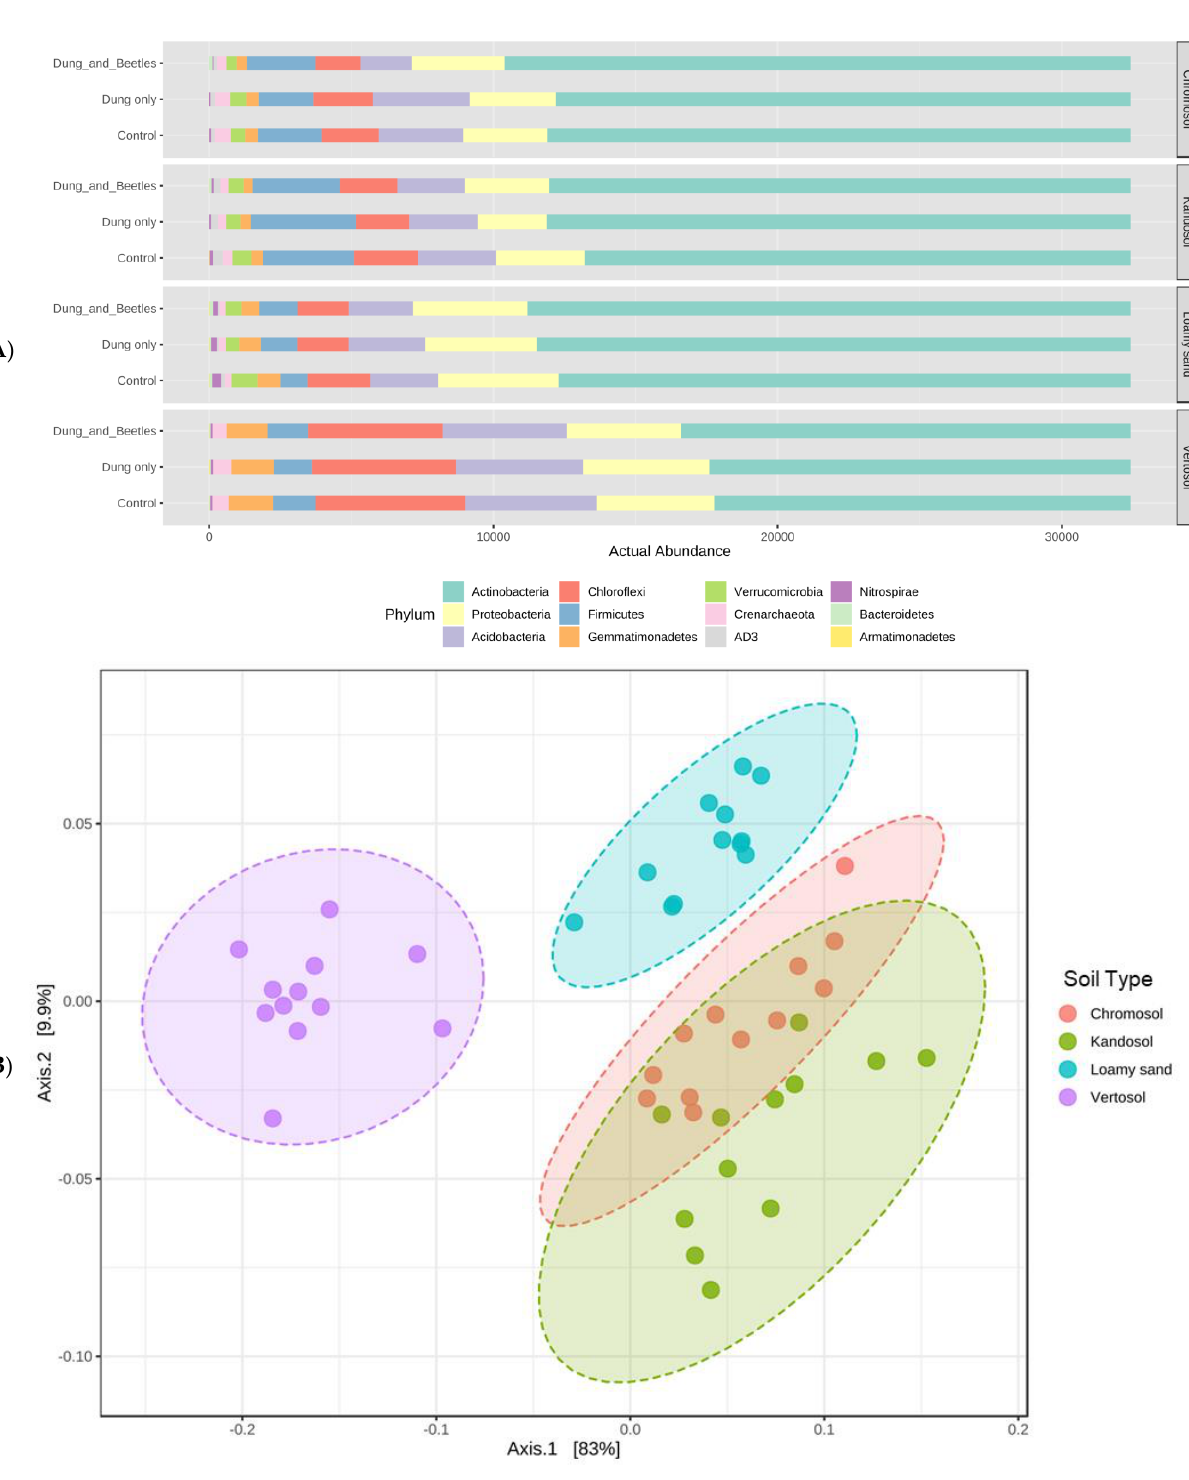
Figure 4. The rhizobacterial community assembly in the different soil types assessed in response to the control, dung, and dung plus beetle treatments. ( A ) The taxonomic distribution of bacterial communities under different pasture management practices. ( B ) Principal coordinate analysis of 16 s rRNA diversity in the rhizosphere of the different soils assessed (data from all treatment types combined due to similarity of the treatment effect).